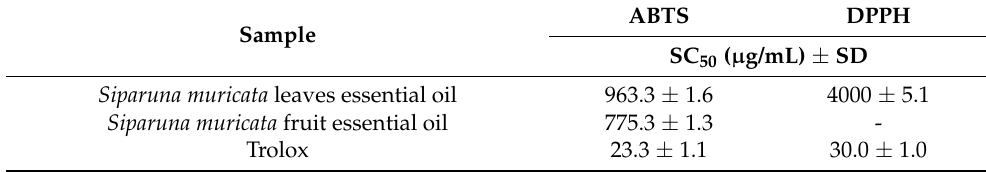
Table 4. Antioxidant activity of essential oil from the leaves and fruits of Siparuna muricata